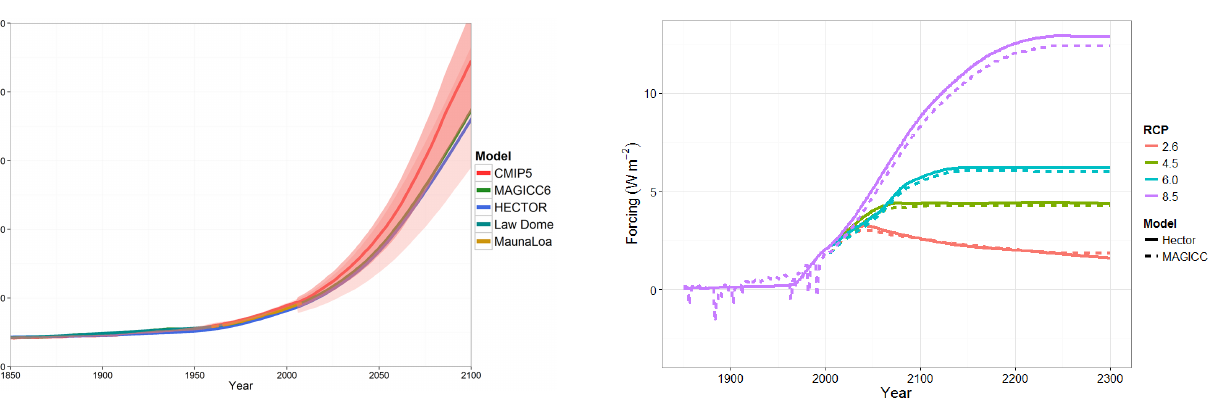
Figure 7. Relative radiative forcing from 1850 to 2300 for Hec- tor (solid) and MAGICC6 (dashed) for all four RCP scenarios: 2.6 (red), 4.5 (green), 6.0 (blue), and 8.5 (purple). Hector has the option to enable or disable radiative forcing from historical volcanic emis- sions. We have opted to disable this for ease of comparison across all